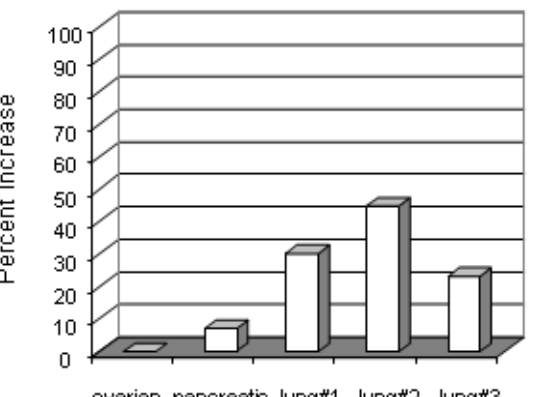
Figure 6. Serum levels of anti-mesothelin antibody increases after treatment. Pre- and post- treatment sera were collected from 5 patients (3 lung cancer, 1 ovarian, 1 pancreatic) and screened for antibodies against mesothelin by ELISA. Data represent the percent increase in units of post-treatment sera over the corresponding pre-treatment sera OD 450nm